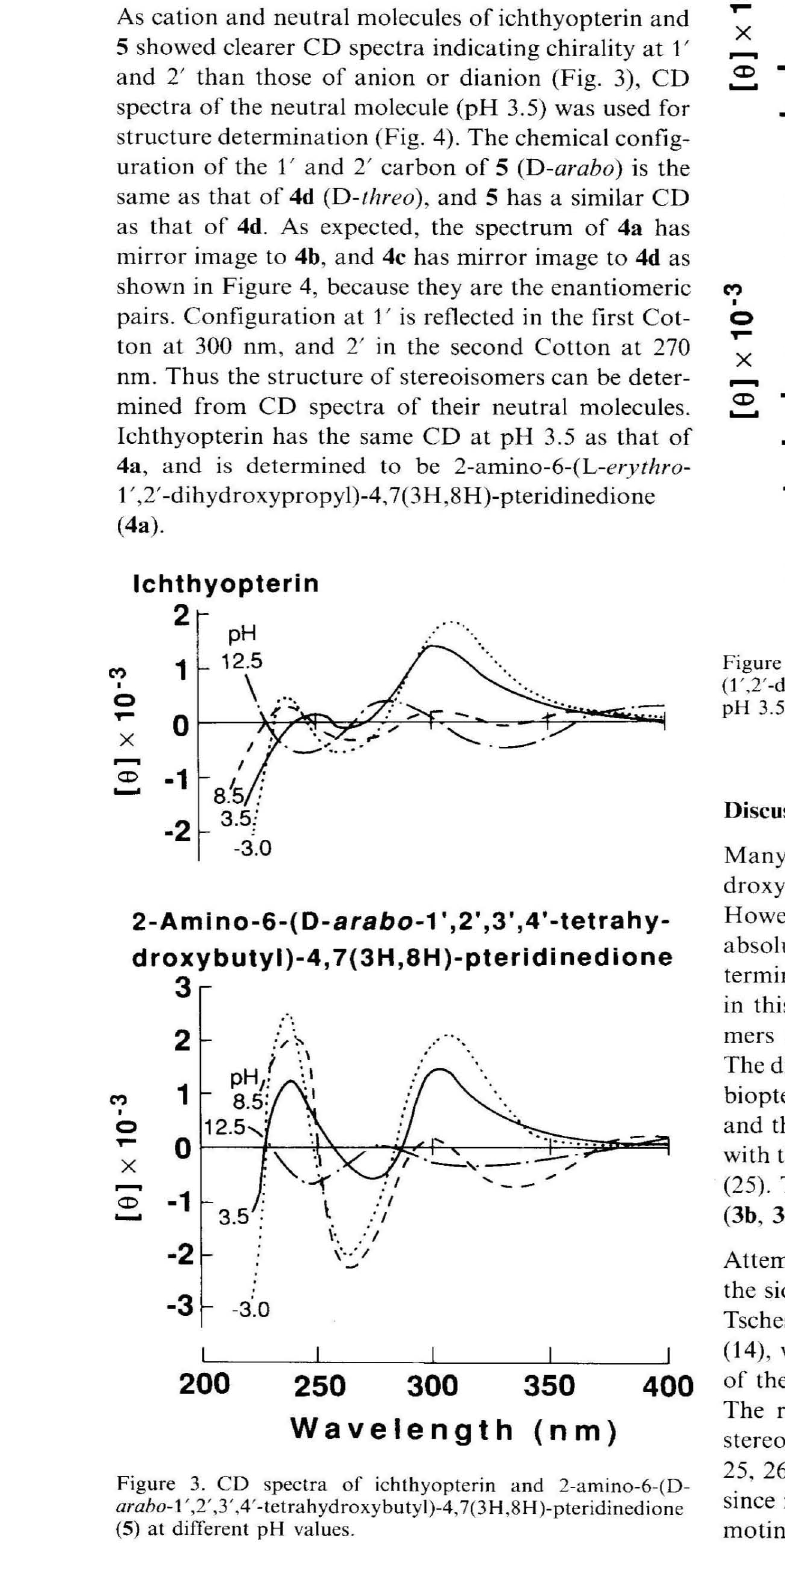
Figure 3. CD spectra of ichthyopterin and 2-amino-6-(D arabo-1' ,2' ,3',4' -tetrahydroxy butyl)-4, 7(3 H,S H )-pteridinedione (5) at different pH values.